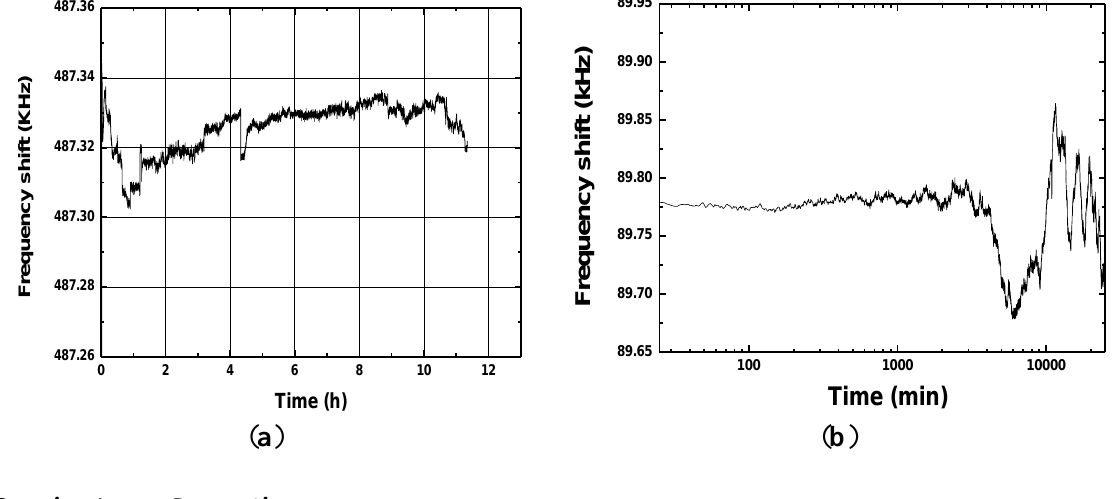
Figure 5. ( a ) The measured medium-term, and ( b ) long-term frequency stability of the developed SAW